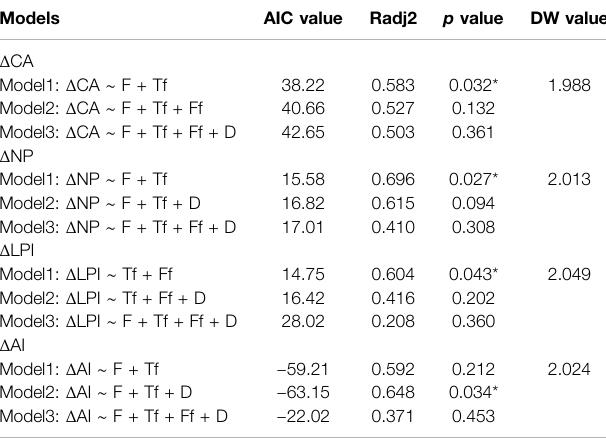
TABLE 5 | Comparison and selection of the optimal general linear models (GLMs) analyzing the in fl uences on changes of landscape metrics of S. alterni fl ora during annual peak growing